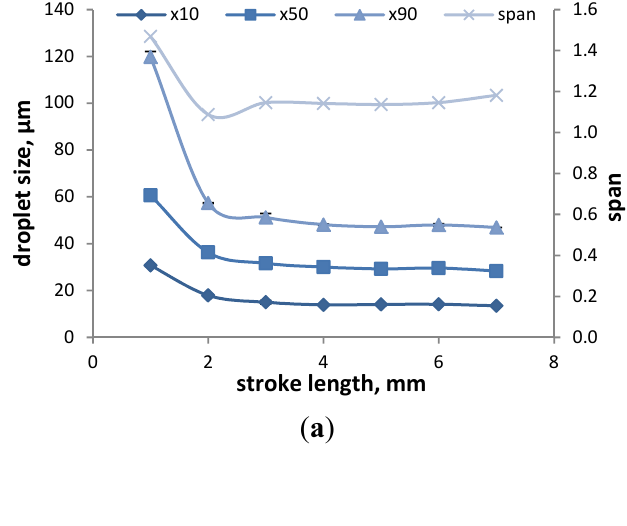
Figure 3. The effect of stroke length ( a ) and actuation force ( b ) on the DSD and span of the model formulation (water) measured at 7 cm from the nozzle. The results represent the average ± SD of three